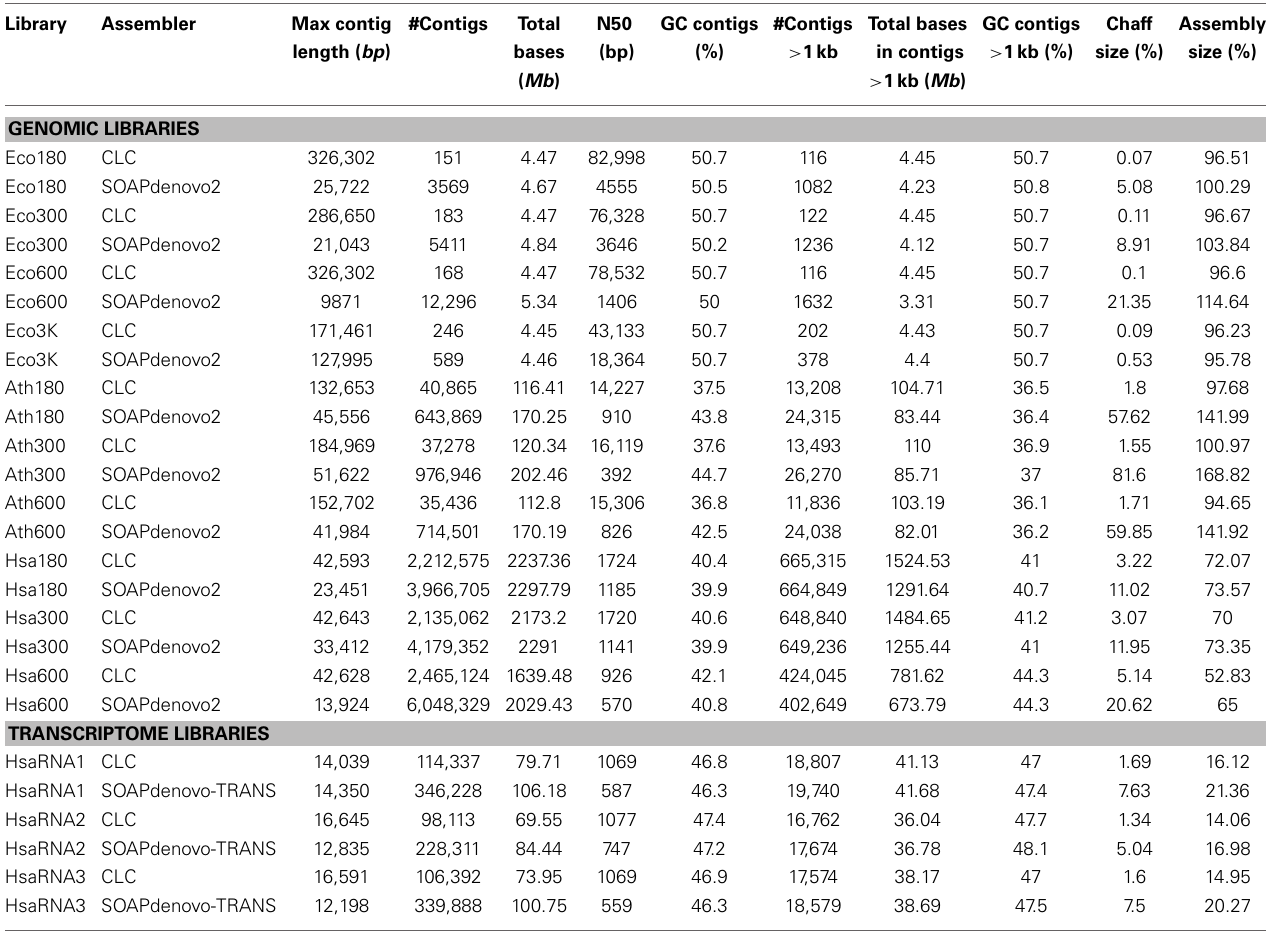
Table 2 | Assembly